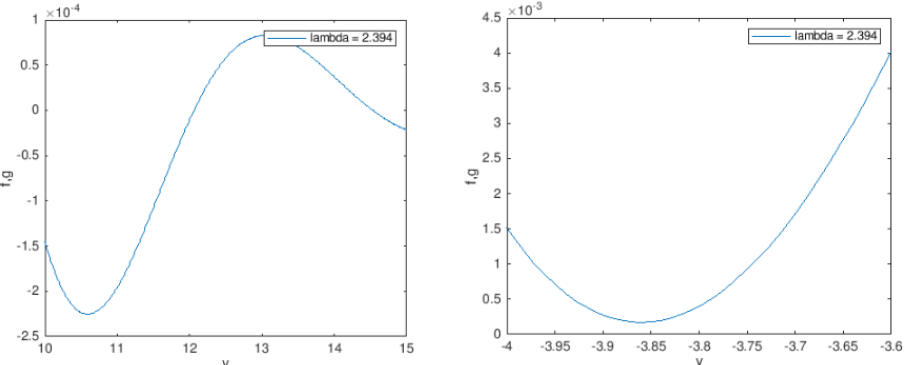
Figure 3. TW solutions for ( λ = 2.394) with a zoom to show the oscillatory sing-changing character in the TW-tail. Note that both solutions f , g are superposed and represented by the blue